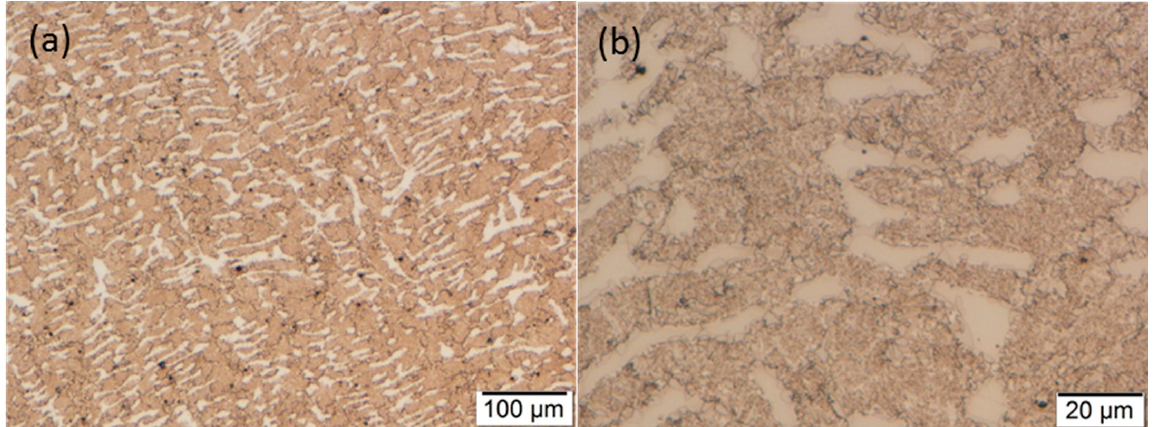
Figure 3. Optical microscopy of the forged complex microstructure, etched with 10% nital, ferrite––white, and austenite and carbides––darker brown; ( a ) the microstructure retained the dendritic morphology, ( b ) some enhanced grain boundaries––possible precipitation.